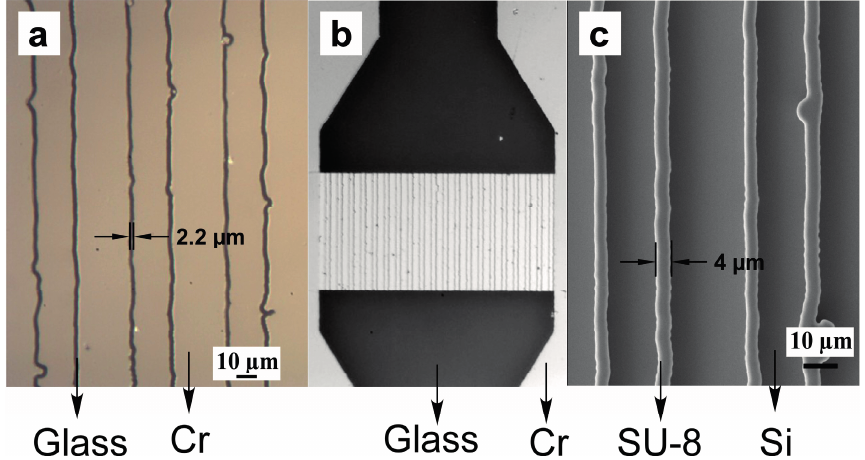
Figure 5. Optical and SEM micrographs of the homemade Cr mask utilized to form an array of Cr microgaps ( a ) within a microfluidic channel ( b ). This mask is then used to photolithographically pattern SU-8 photoresist in order to realize an array of rectangular-shaped micro-pillars ( c